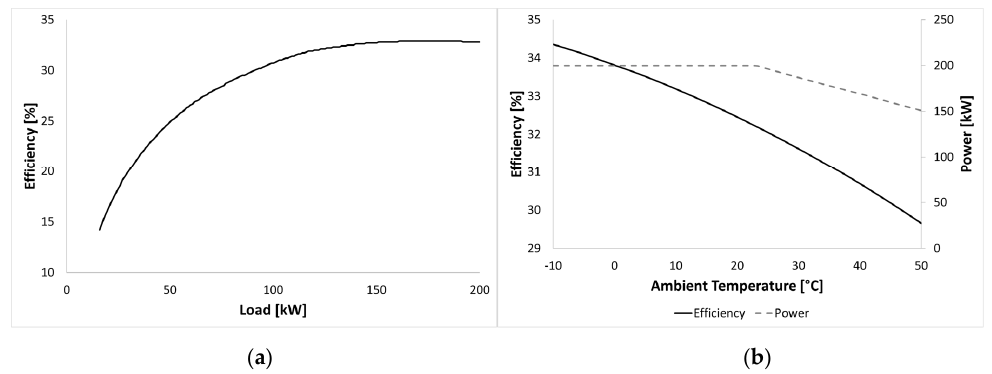
Figure 3. The efficiency of the micro-gas turbine (mGT) with a variation of the load ( a ) and the influence of the ambient temperature on the efficiency and power output ( b ).